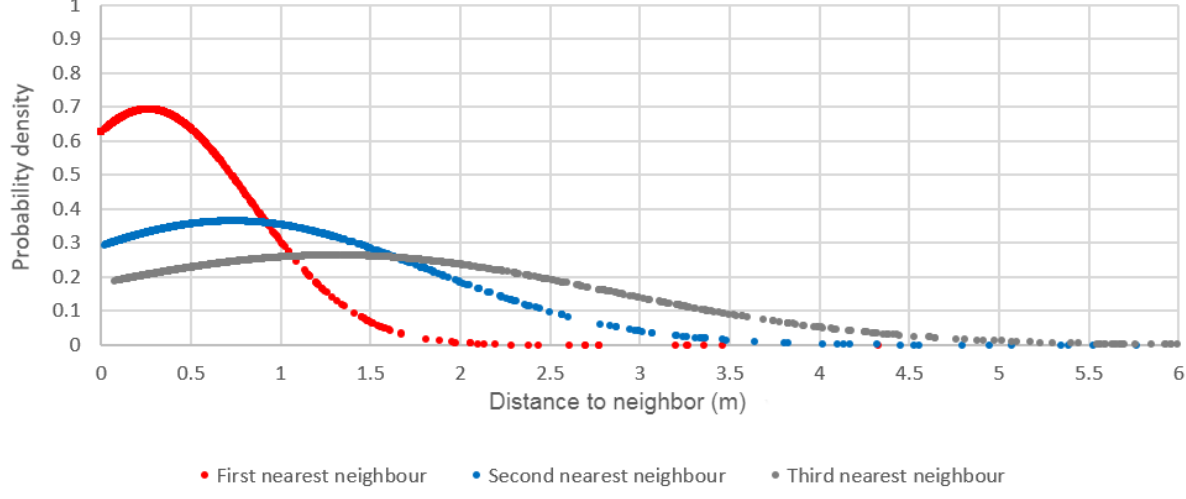
Figure 3. Normalized distribution of the distance between dwellings and their first, second, and third nearest neighbors in